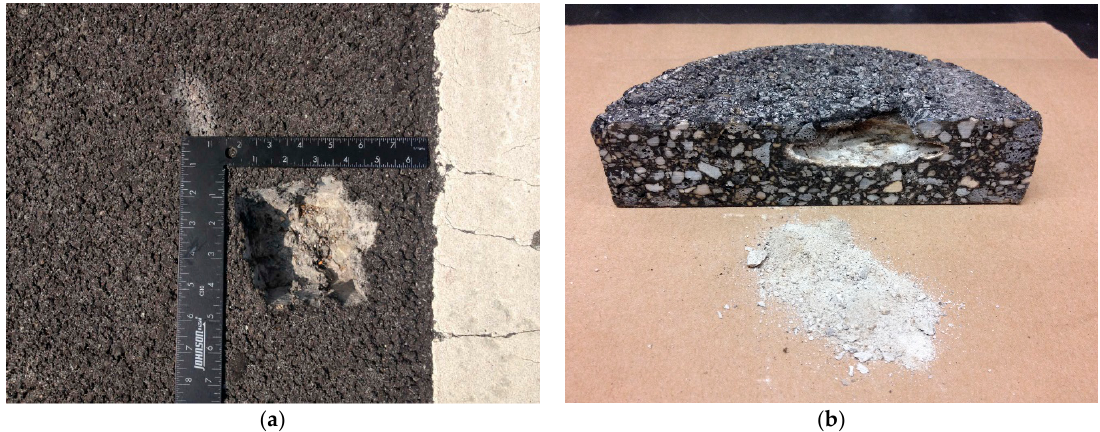
Figure 1. Field observation of clay ball. ( a ) Opened and cleaned clay ball; ( b ) sliced core from clay ball area.